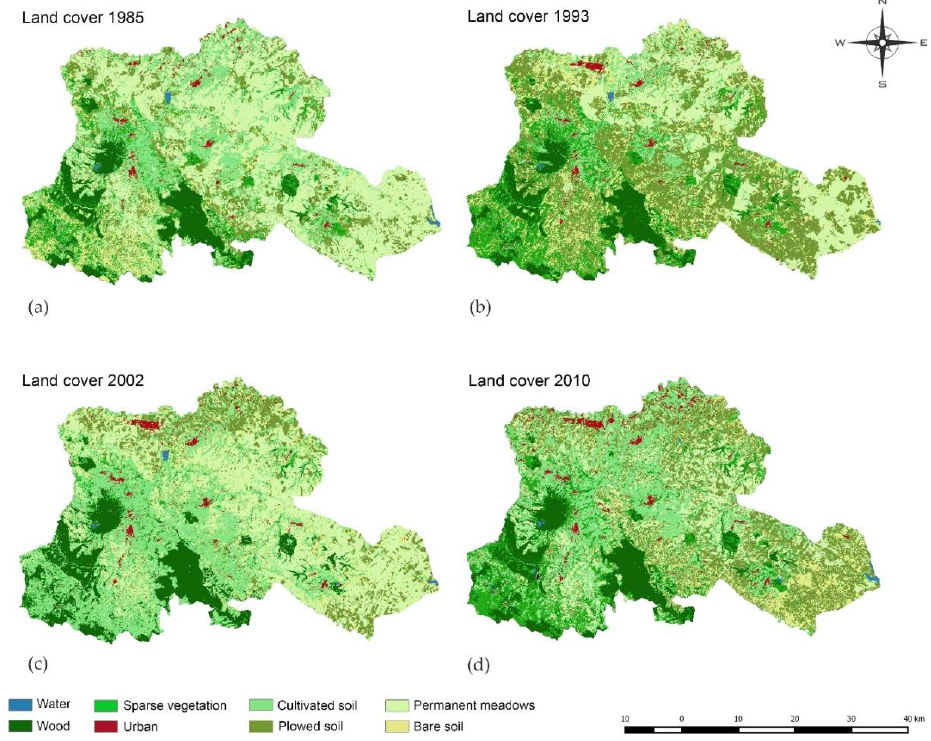
Figure 4. ( a–d ) Classification of the Vulture Alto-Bradano area for four dates. Figure 4. (a–d) Classification of the Vulture Alto-Bradano area for four